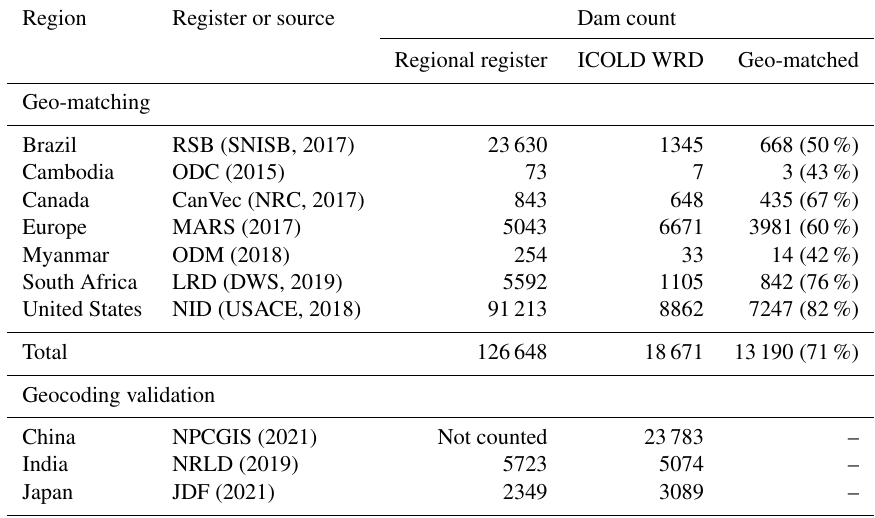
Table 2. Regional registers or inventories for geo-matching and the validation of geocoding.